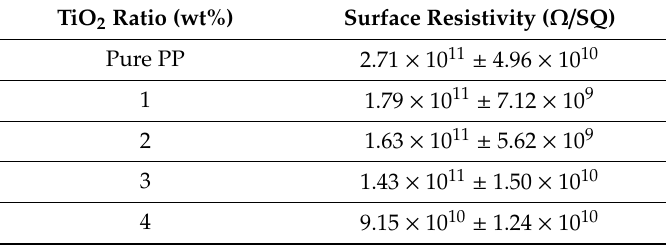
Table 3. Surface resistivity of melt-blown fabrics as related to the TiO 2